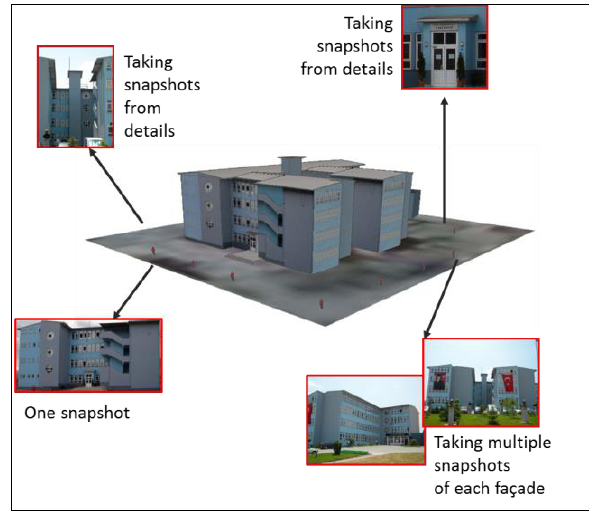
Figure 4. Taking pictures from different views